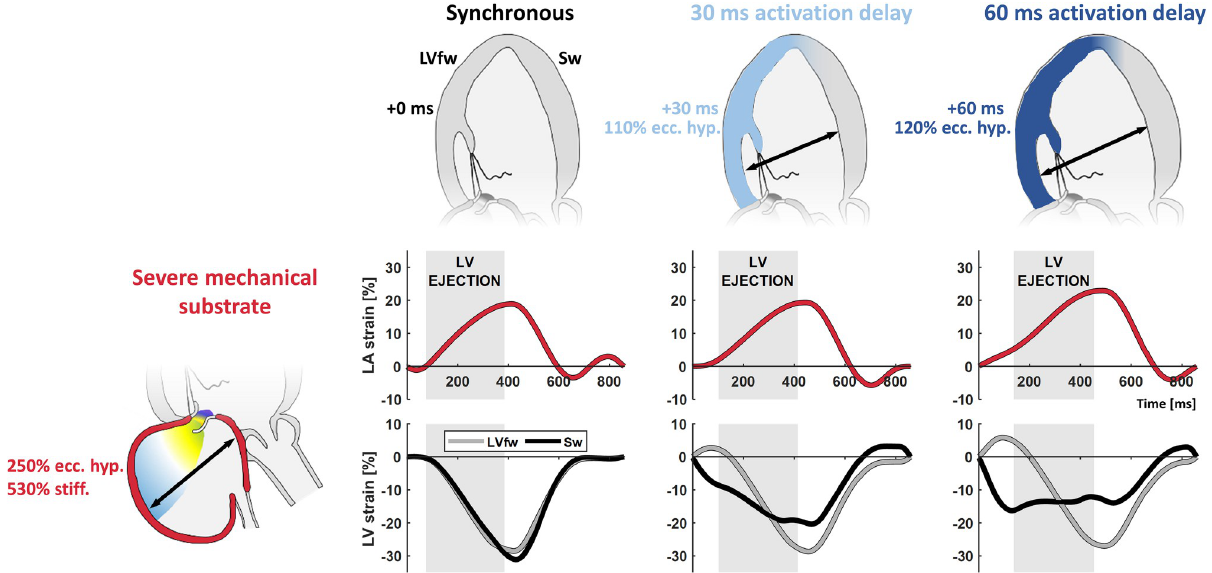
Fig 6. Simulations of LA and LV strain with MR after induction of LBBB. Effect of increasing LV electromechanical activation delay in addition to acute MR. Electromechanical activation delay is characterized by a delayed onset of LV filling, increased LAS(r) and decreased LAS(ct). Vertical gray areas in the strain panels indicate the period of LV ejection. LVfw = left ventricular free wall; Sw = septal wall; ecc. hyp. = eccentric hypertrophy; stiff. = passive stiffness.